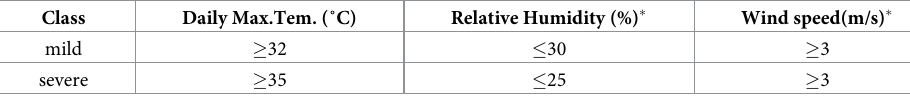
Table 1. Classification of dry hot wind.